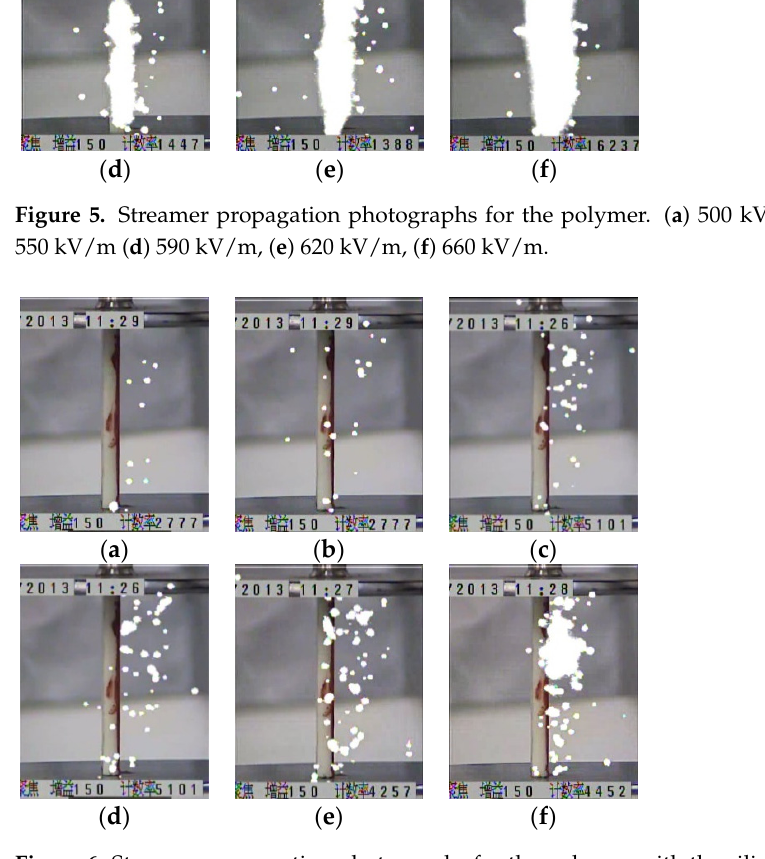
Figure 6. Streamer propagation photographs for the polymer with the silicone rubber coating. ( a ) 510 kV/m, ( b ) 540 kV/m, ( c ) 560 kV/m, ( d ) 590 kV/m, ( e ) 630 kV/m, ( f ) 660 kV/m.